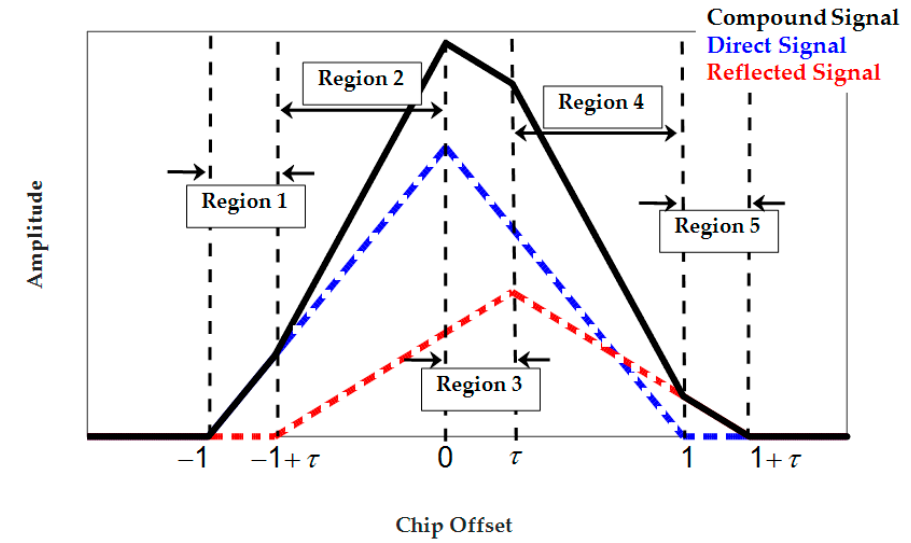
Figure 5. BPSK(1) correlation peak and its distortion under a single-ray multipath.